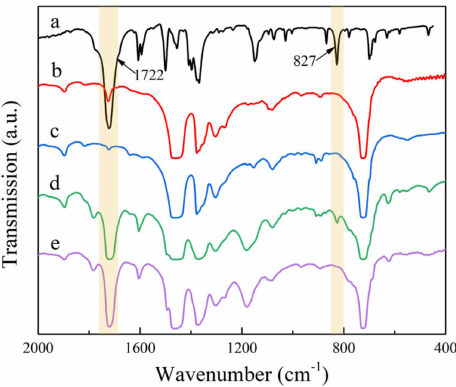
Figure 2. FTIR spectra of ( a ) HVA-2, ( b ) crosslinkable PE, ( c ) XLPE, ( d ) crosslinkable PE containing HVA-2, and ( e )